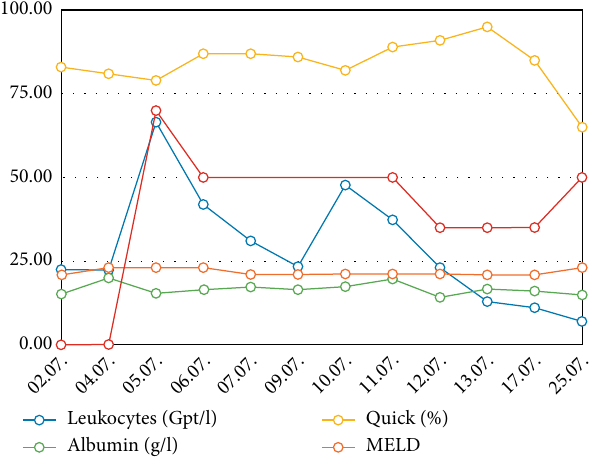
Figure 4: Different laboratory parameters over time. MELD: Model of endstage liver disease-score.